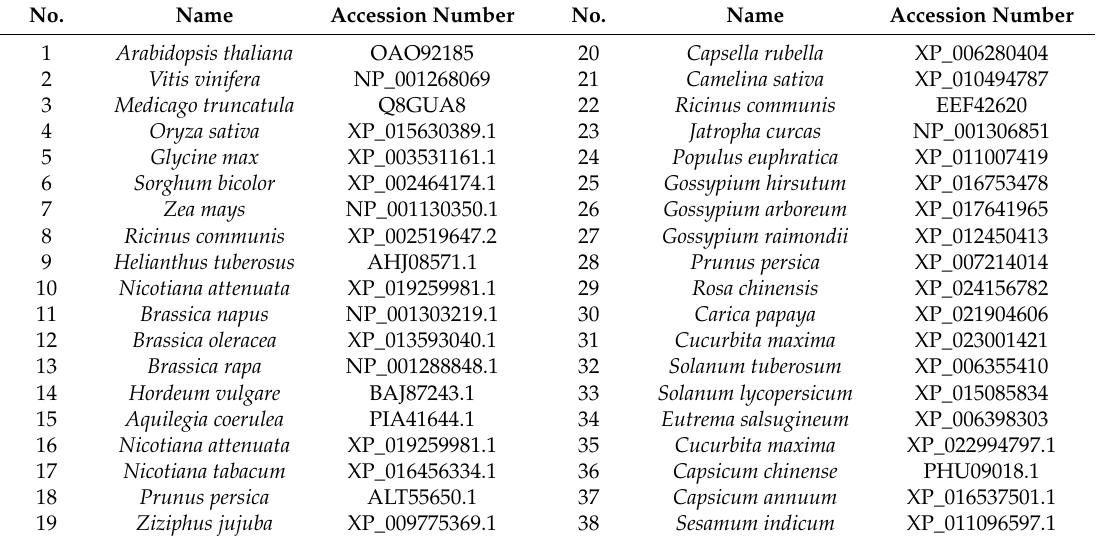
Table 1. OAT enzymes identified in different plant